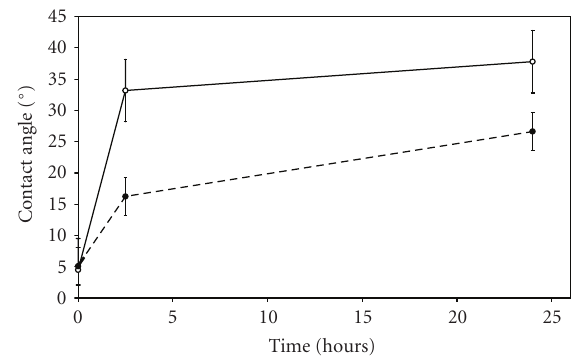
Figure 2: Water droplet contact (CA) angle versus exposure time in an evacuated atmosphere for Activ ( ◦ ) and glass ( • ); CA measurements recorded under ambient conditions.